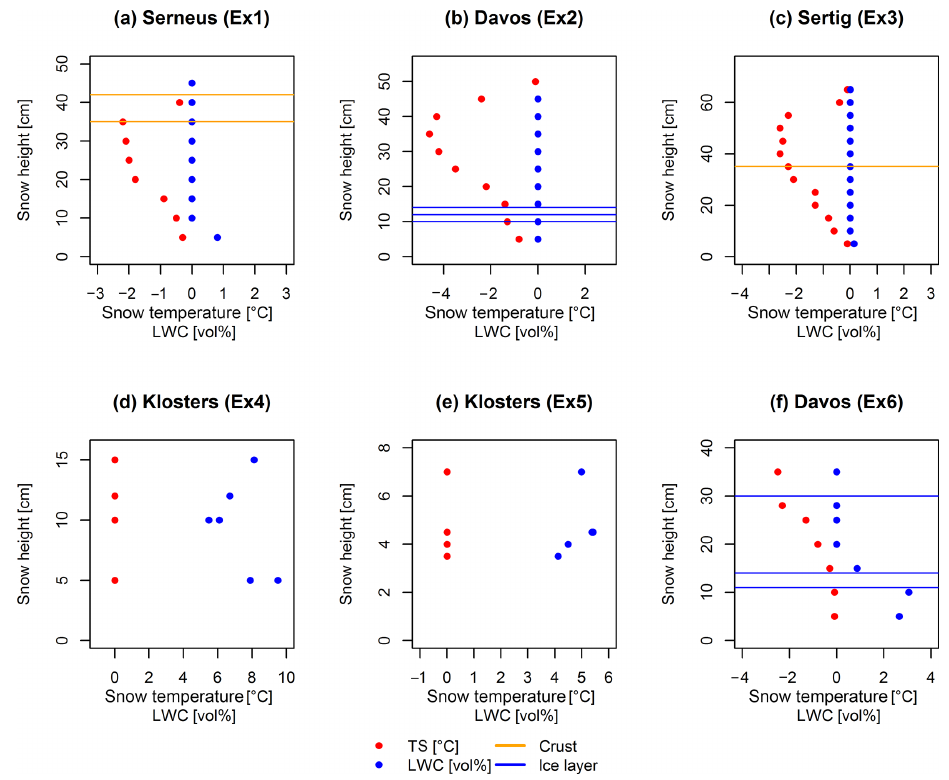
Figure 3. Snow temperature and LWC profiles measured directly before the sprinkling experiment started. The lines represent observed ice layers (blue) and crusts (orange). Table 1. Snowpack pre-conditions and execution dates for the sprinkling experiments as well as R 2 values for the different model simulations. Measured values are snow height (HS), bulk liquid water content (LWC), bulk snow temperature (TS). No snowpack runoff measurements were available for Sertig